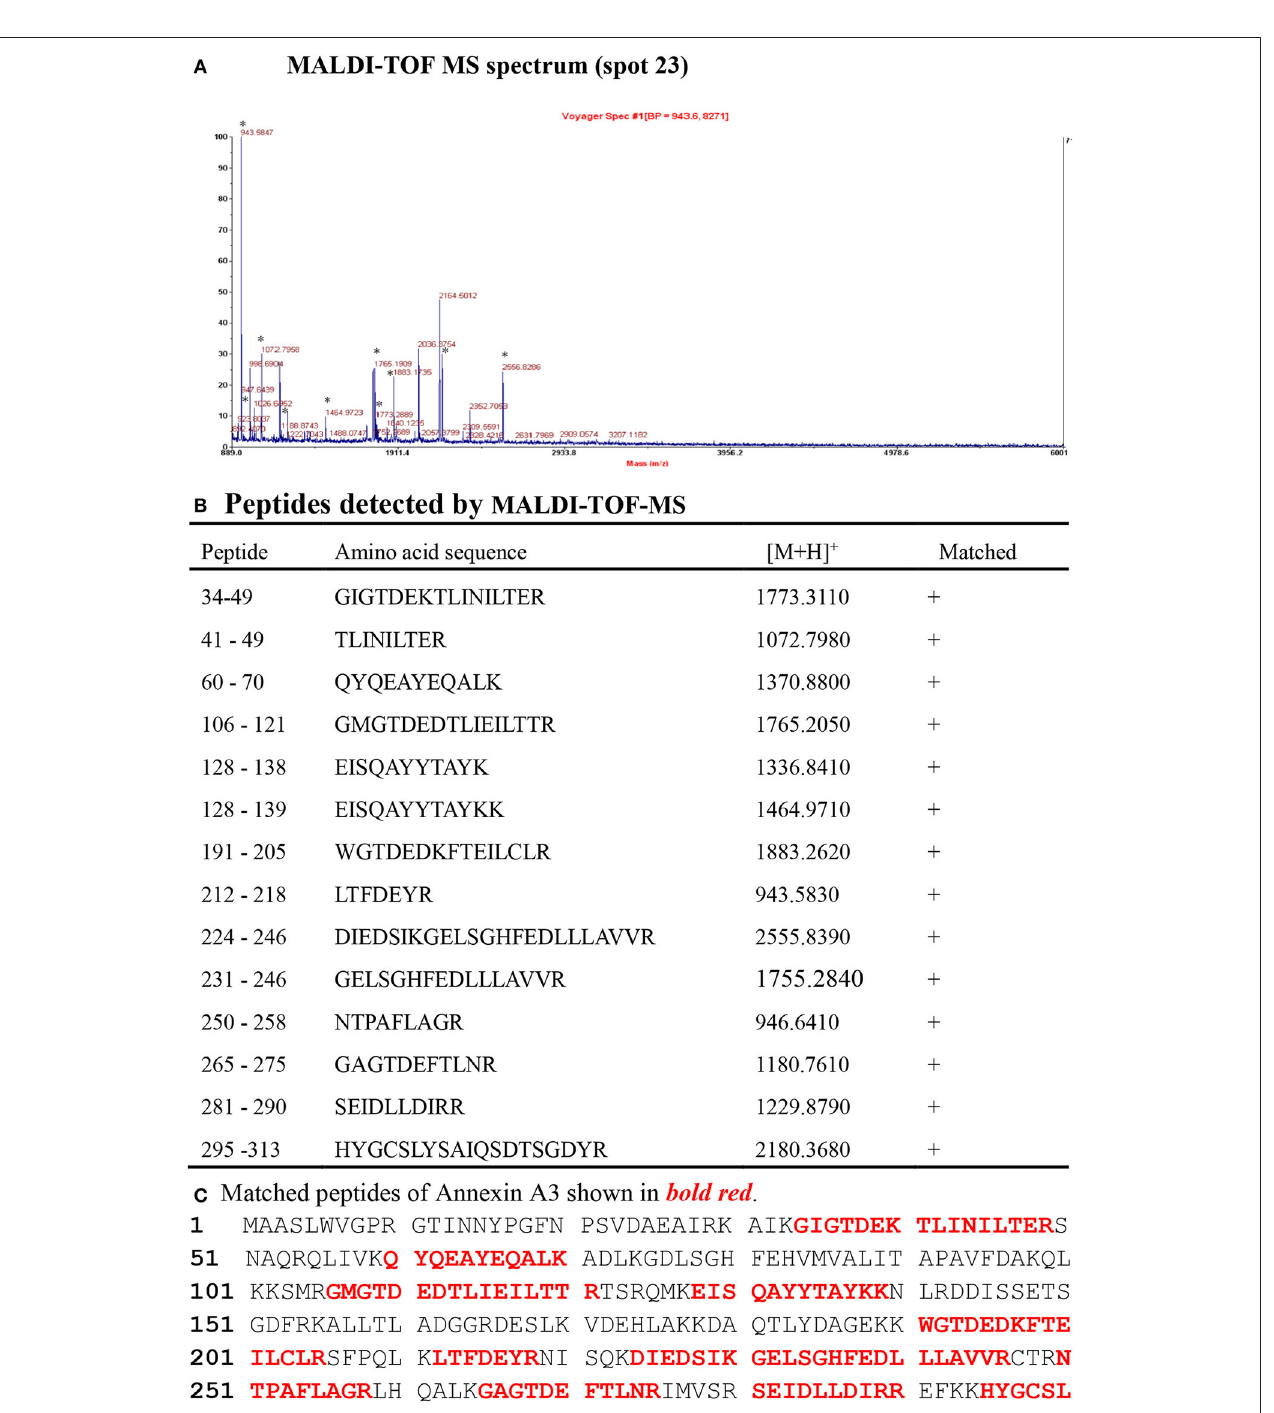
FIGURE 3 | Identification of ANXA3 (Spot 23) with MALDI-TOF-MS peptide mass fingerprint.